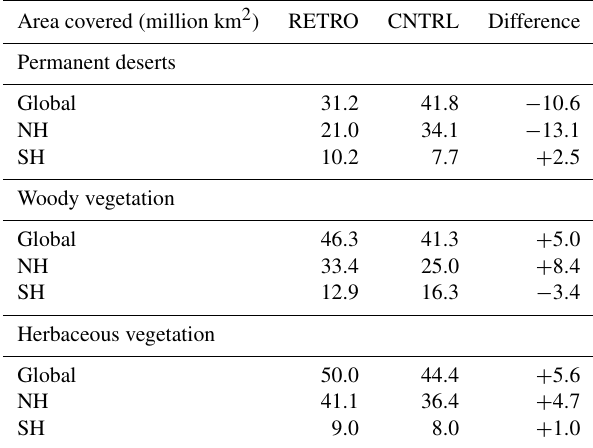
Table 2. Global area of main vegetation groups averaged over the last 1000 years of the